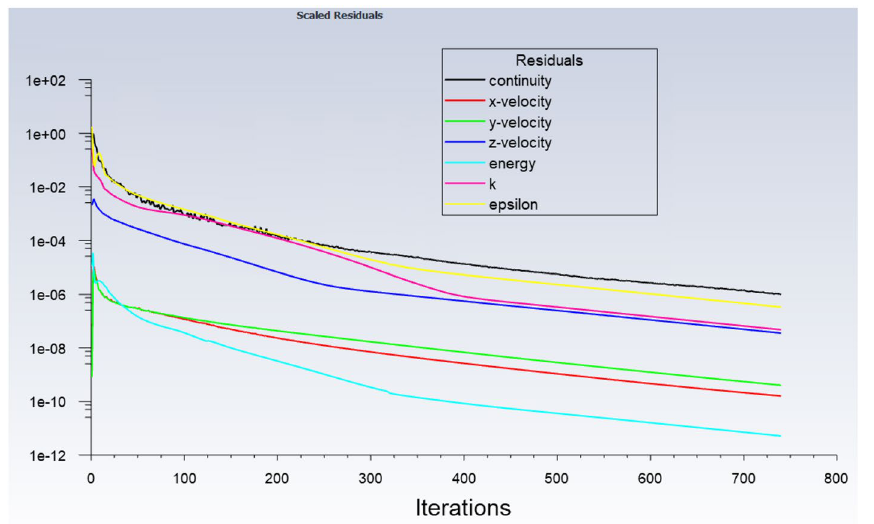
Figure 11. Scaled residual errors.